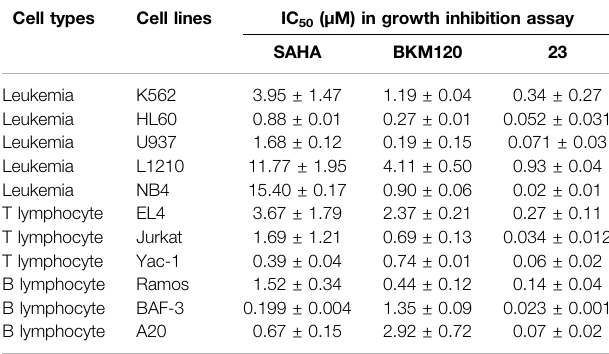
TABLE 1 | Antiproliferative activity of compound 23 against various hematologic cell lines compared with SAHA and BKM120